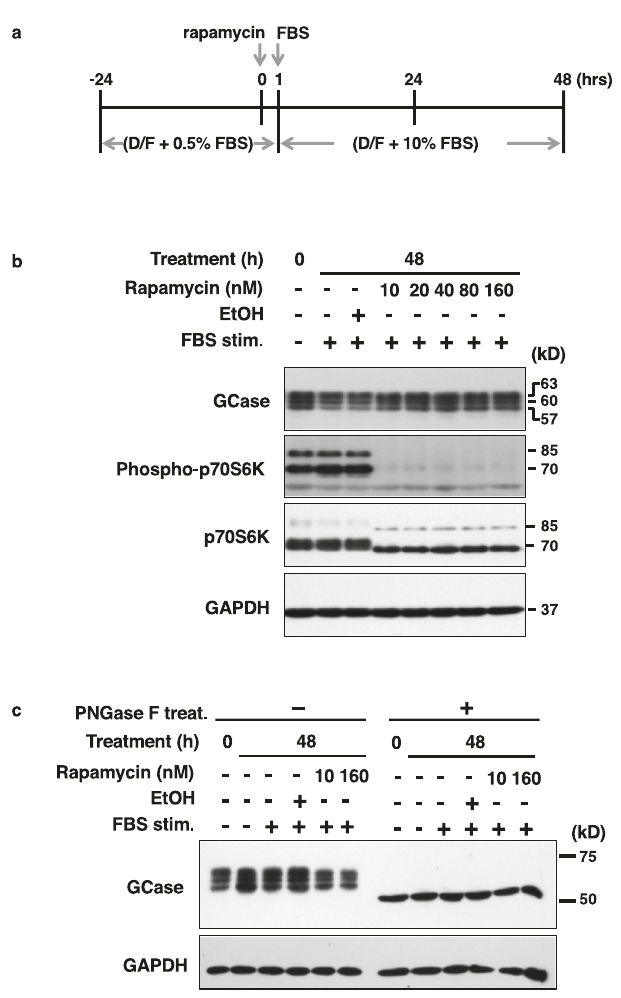
Fig. 7 GCase translation in OF2 cells after rapamycin treatment. a Diagram of sample preparation. OF2 cells were precultured in media with 0.5% FBS for 24 h before rapamycin treatment. The cells were treated rapamycin for 1 h, FBS was added up to 10% and maintained for 48 h. b Results of GCase expression in rapamycin-treated OF2 cells, as determined by western blot analysis. EtOH; 0.1% ethanol, FBS stim.; FBS stimulation. c Con fi rmation of the GCase expression remove its glycosylation. Each experiment was performed in the triplicate and representative data was